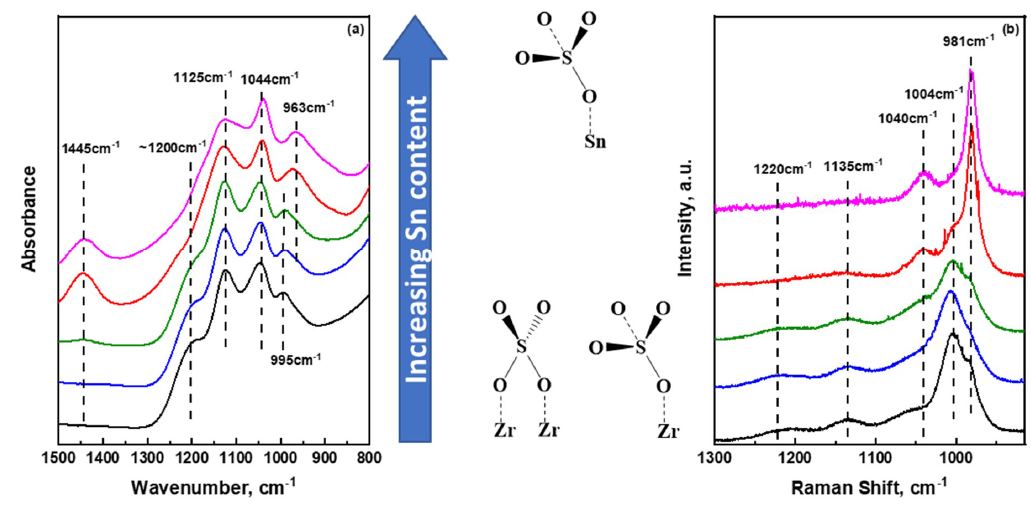
Figure 3. Ambient temperature ( a ) FTIR and ( b ) Raman spectra of sulfated single as well as mixed (SO 42− ) SnO 2 /ZrO 2 oxides at the spectral regime where characteristic vibrational modes of sulfate species can be observed. The spectra have been organized from ZrO 2 -rich (bottom) to SnO 2 -rich (top) samples.